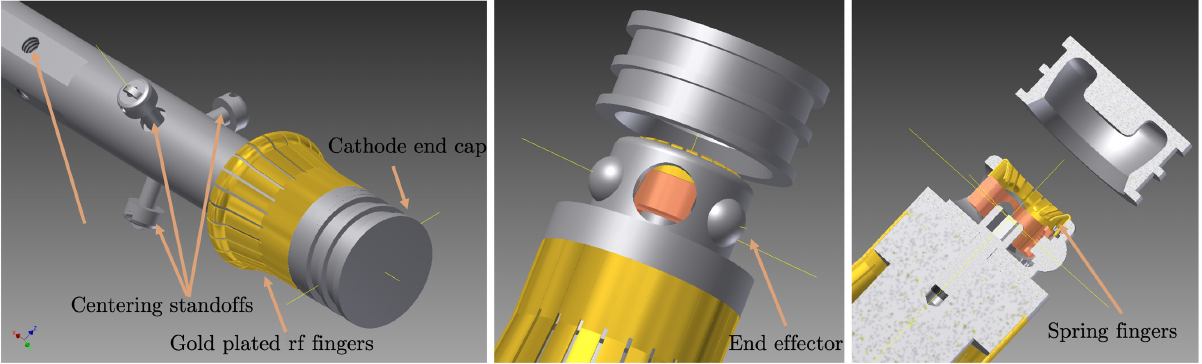
FIG. 2. Detailed schematic of the cathode puck and cathode manipulator end effector assembly.